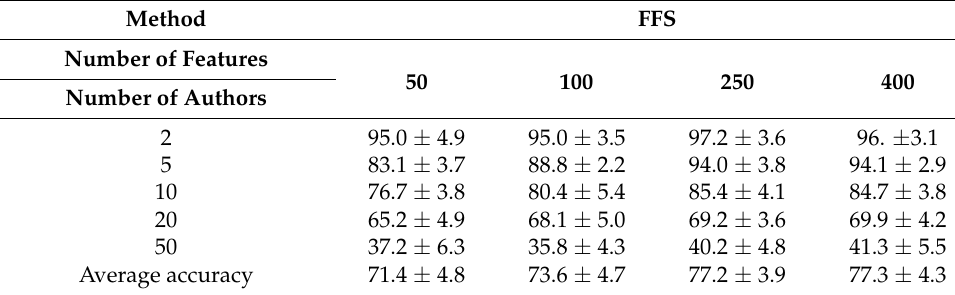
Table 5. Feature selection methods